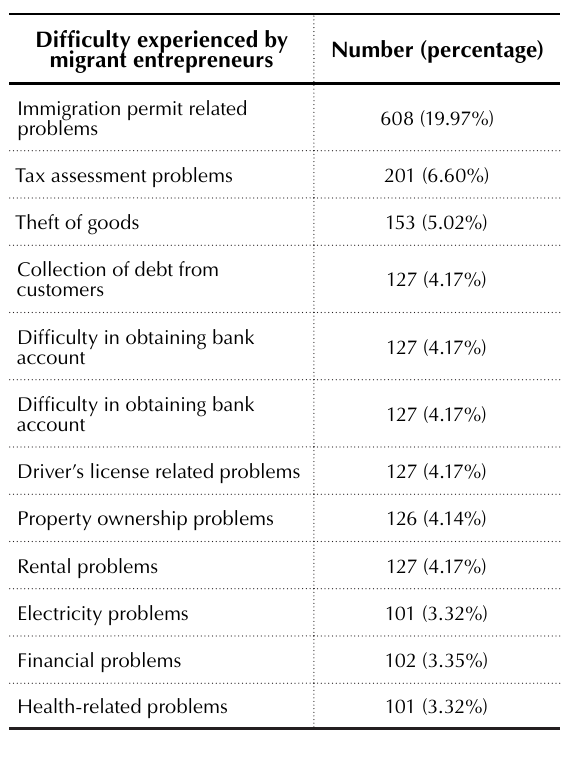
Table 1. General characteristics of migrant entrepreneurs ( n =